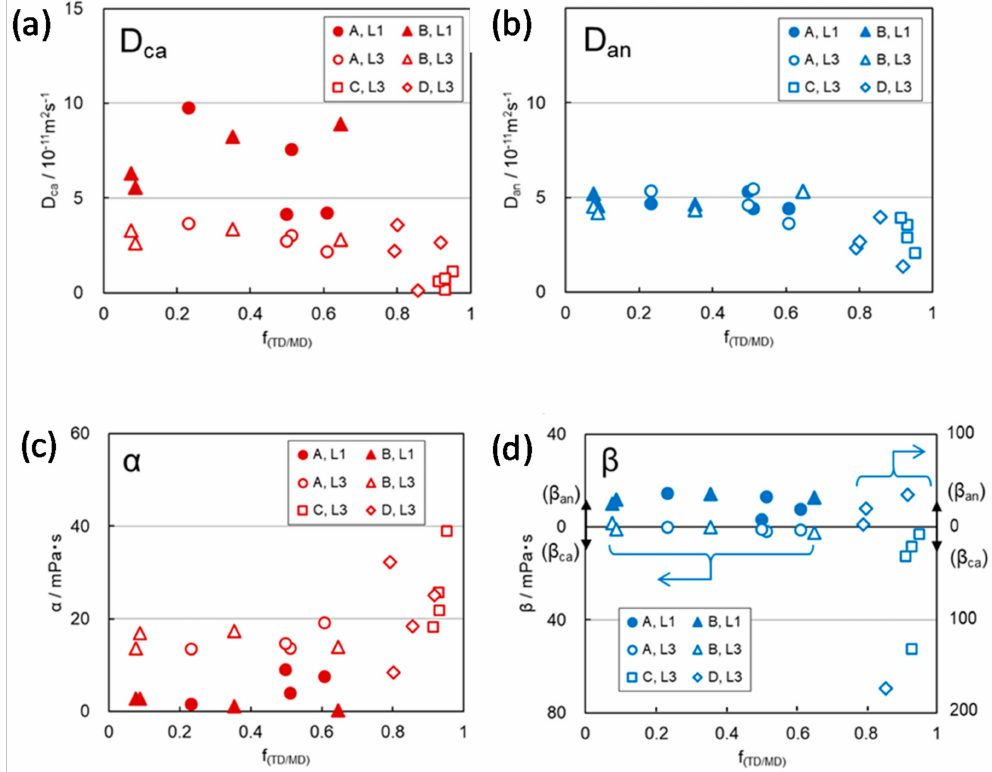
Figure 12. Estimated ( a ) D ca , ( b ) D an , ( c ) α , and ( d ) β ca , β an of PE membranes of A and B groups using L1 and L3 solution and the membranes of C and D groups using L3 solution as a function of anisotropy index, f (TD/MD) . Reprinted with permission from [15]. Copyright 2020 ACS